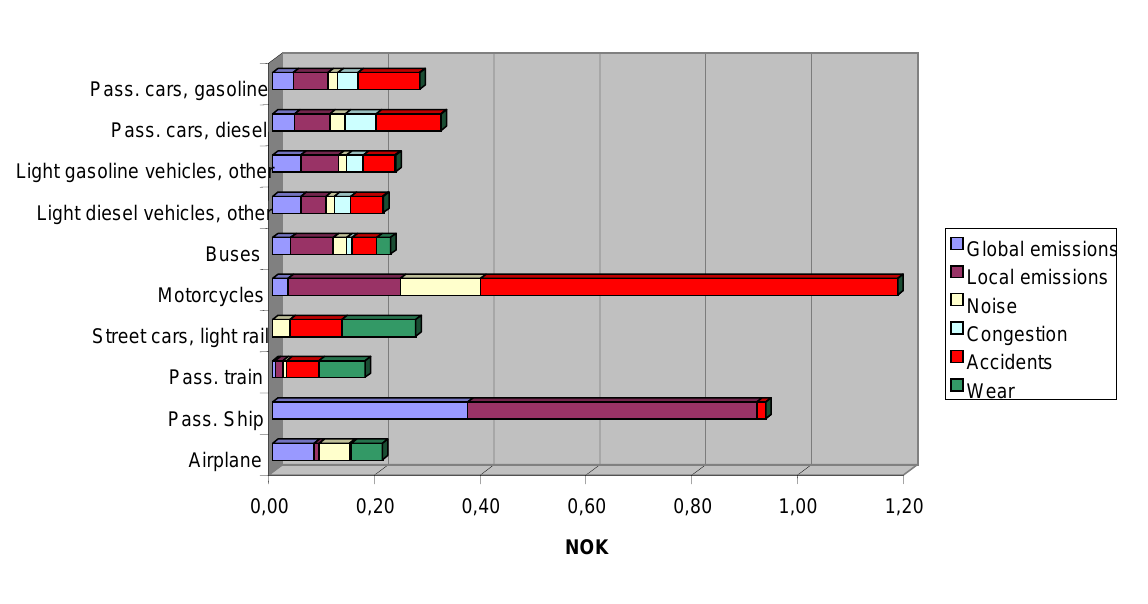
Figure 1. Marginal external costs per passenger km.